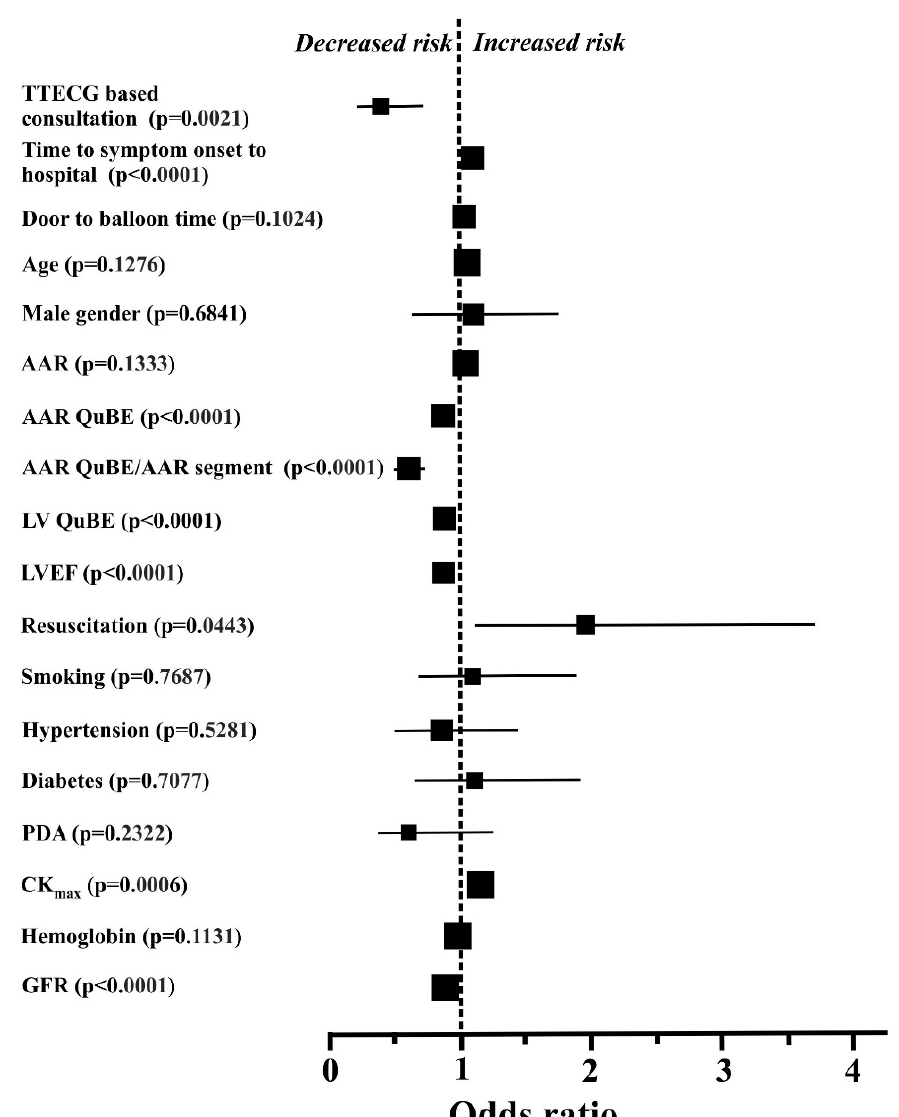
Figure 3. Odds ratios and 95% confidence intervals for hospital mortality in the individual sub- groups, defined on the basis of baseline characteristics, blood chemistry, and percutaneous coronary intervention-related procedural data. Only selected parameters, and variables displaying a p value of p < 0.2 with the comparative analysis are shown. The sizes of the symbols reflect the number of patients in each group. For some parameters (time to symptom onset to hospital, door to balloon time, age, AAR, AAR QuBE, LV QuBE, LVEF, CK max , hemoglobin, and GFR), confidence intervals are within the symbols. AAR = area at risk; CK max = peak creatine kinase level; GFR = glomerular filtration rate; LV = left ventricle; LVEF = left ventricular ejection fraction; PAD = peripheral artery disease; QuBE = blush score; TTECG = transtelephonic